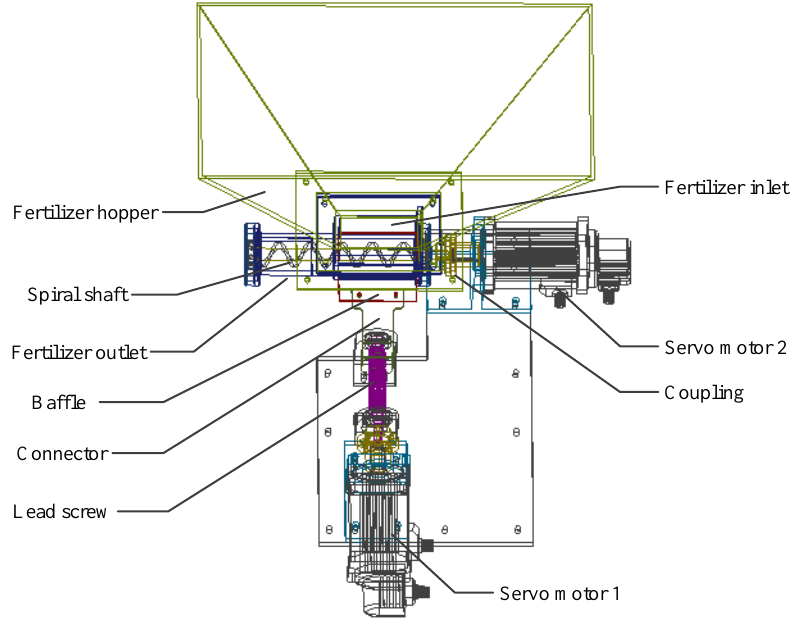
Figure 1. Three-dimensional view of fertilizer applicator.